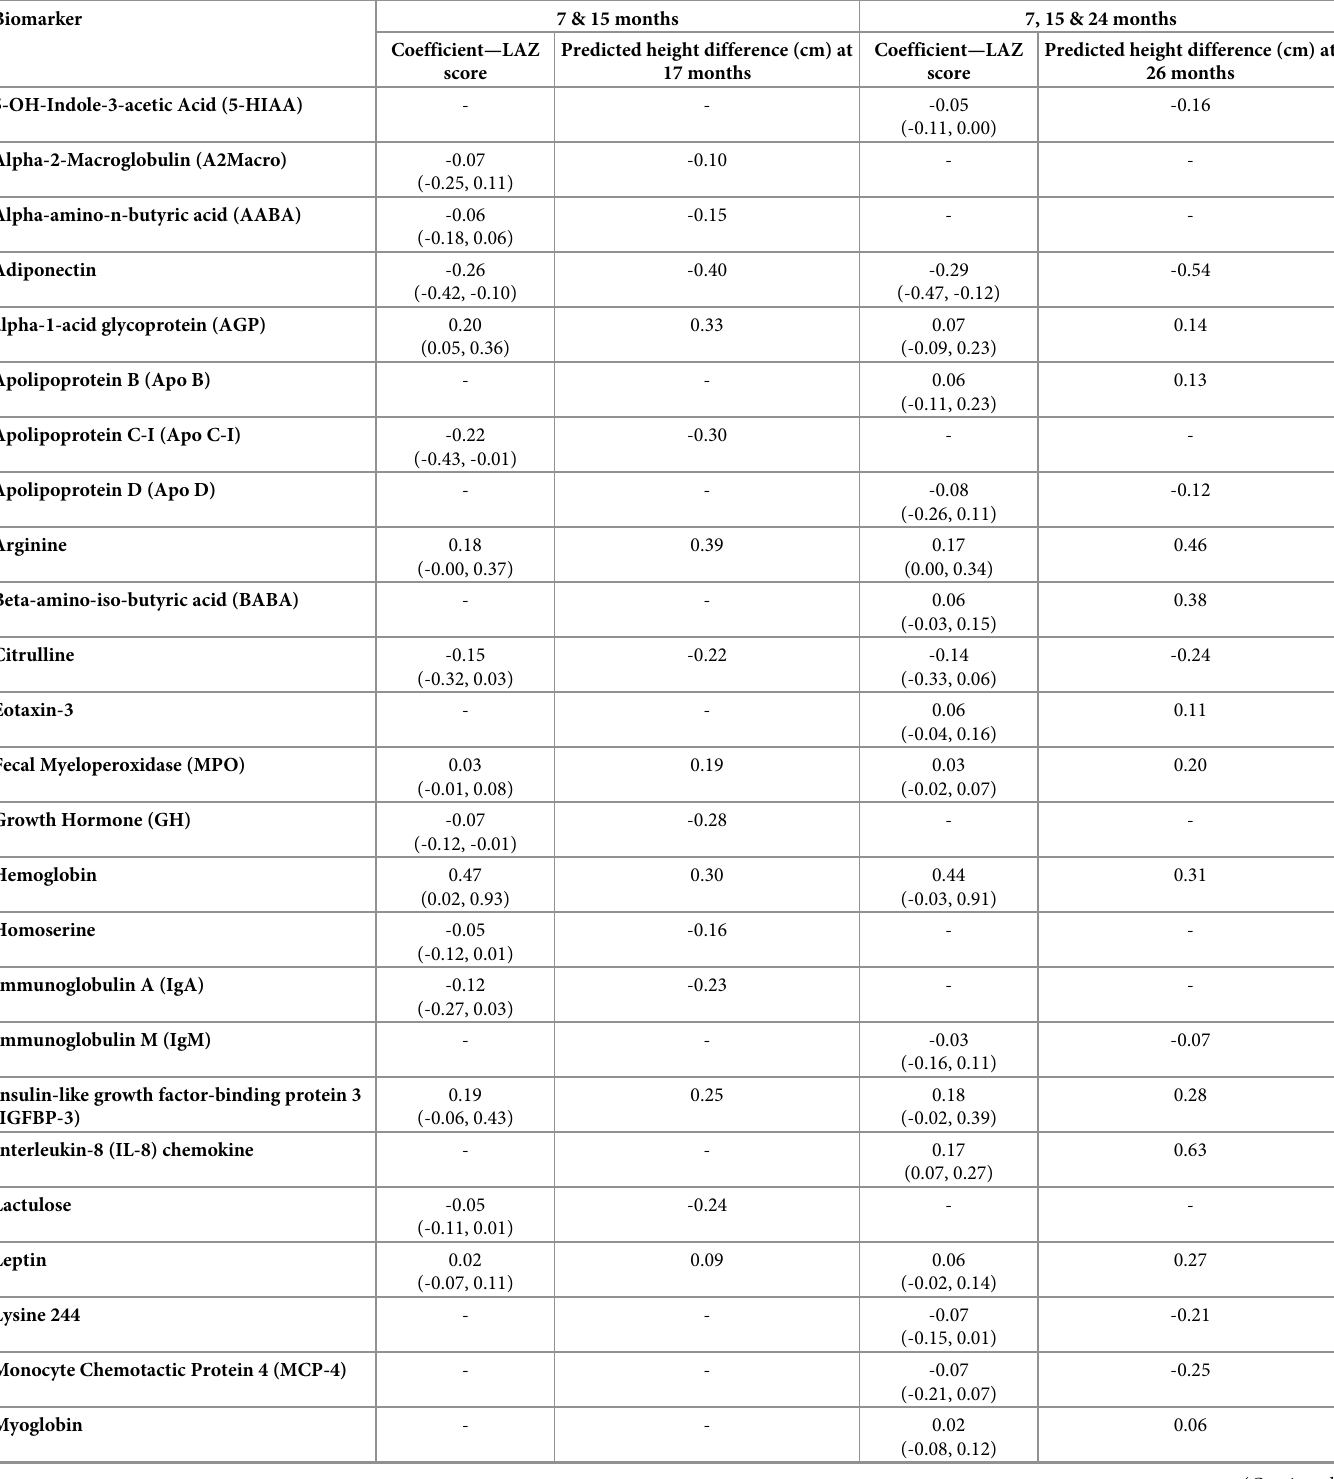
Table 3. Coefficient estimates (with 95% confidence intervals) from linear regression models for biomarkers selected by SCAD along with the predicted difference in child’s height 2 months after the last sample for children at the 25 th and 75 th percentile of the biomarker